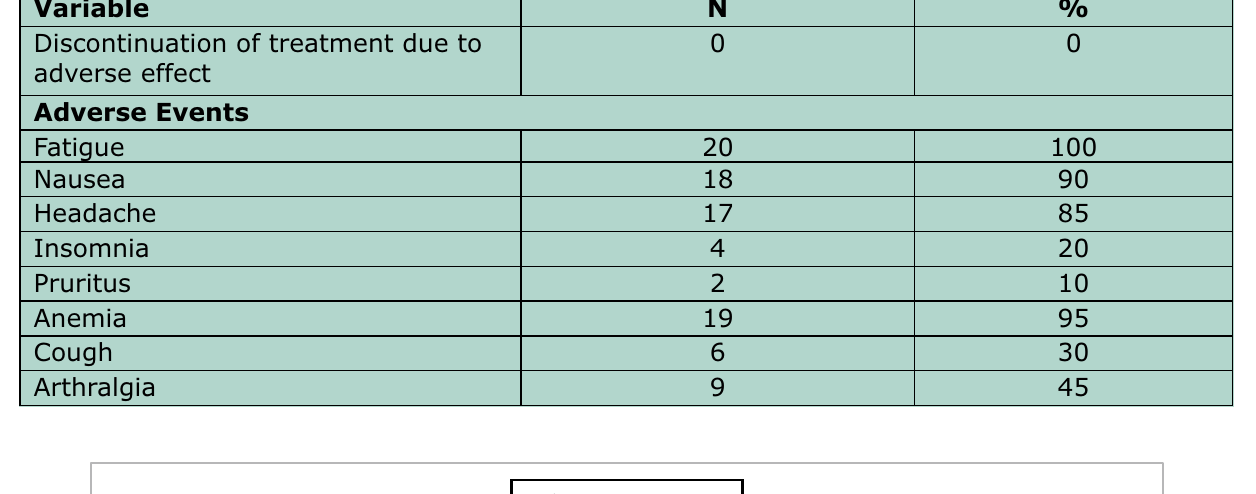
Table-II: Adverse events reported during the study period.